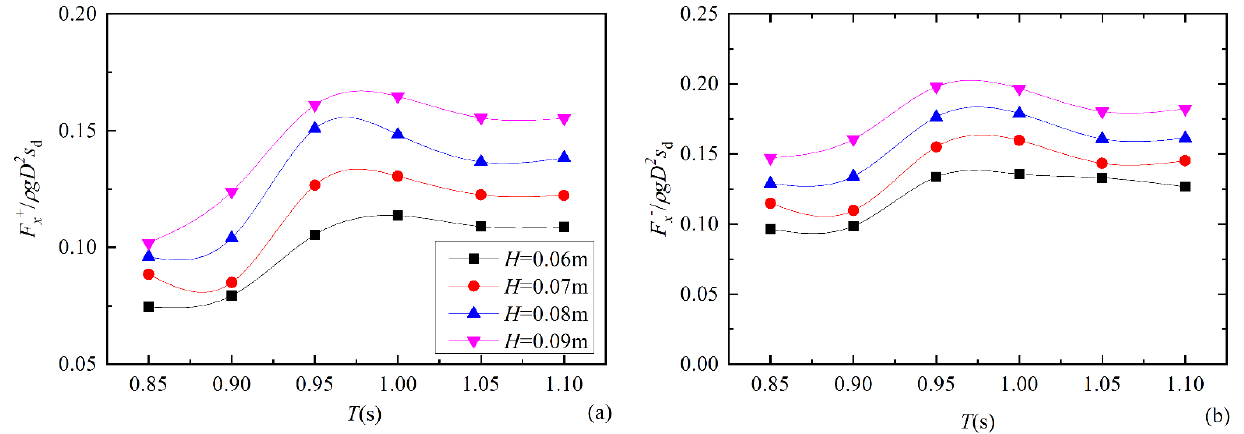
Figure 6. The wave parameter effect on ( a ) positive longitudinal peak force ( F x + ) and ( b ) negative longitudinal peak force ( F x − ).